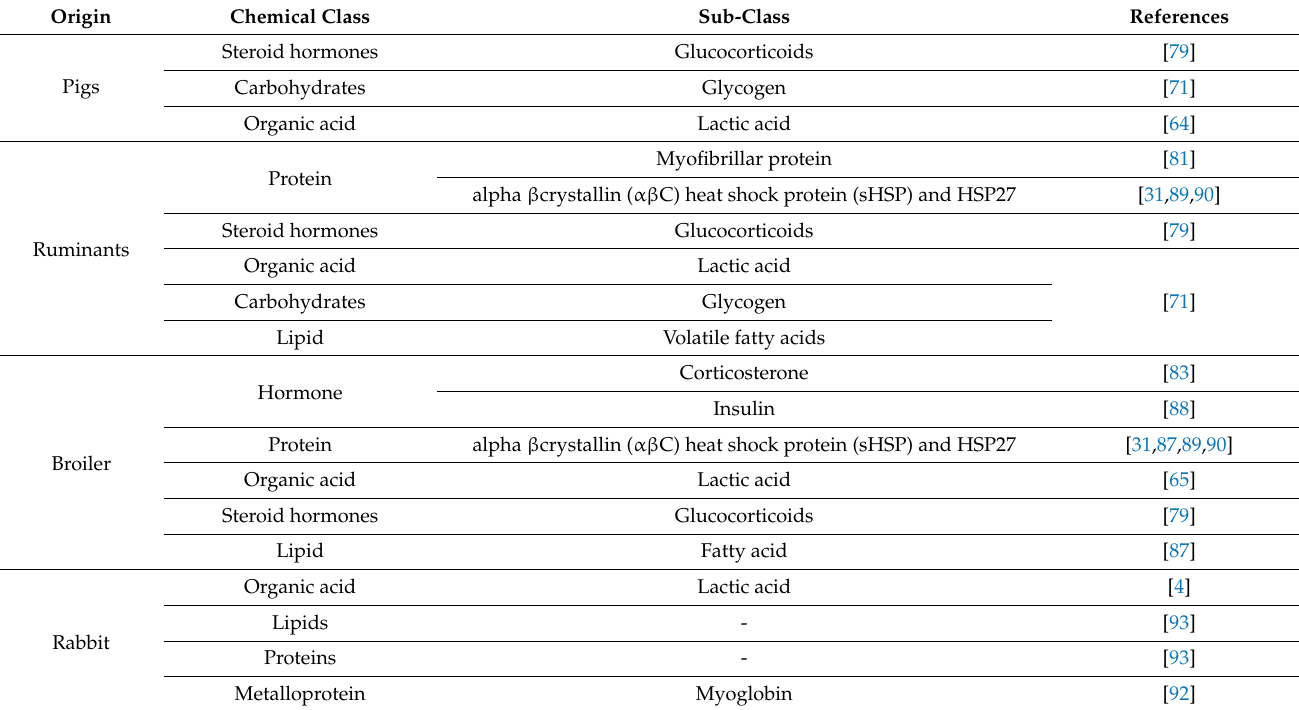
Table 1. Effects of heat stress on biochemical and chemical parameters of the